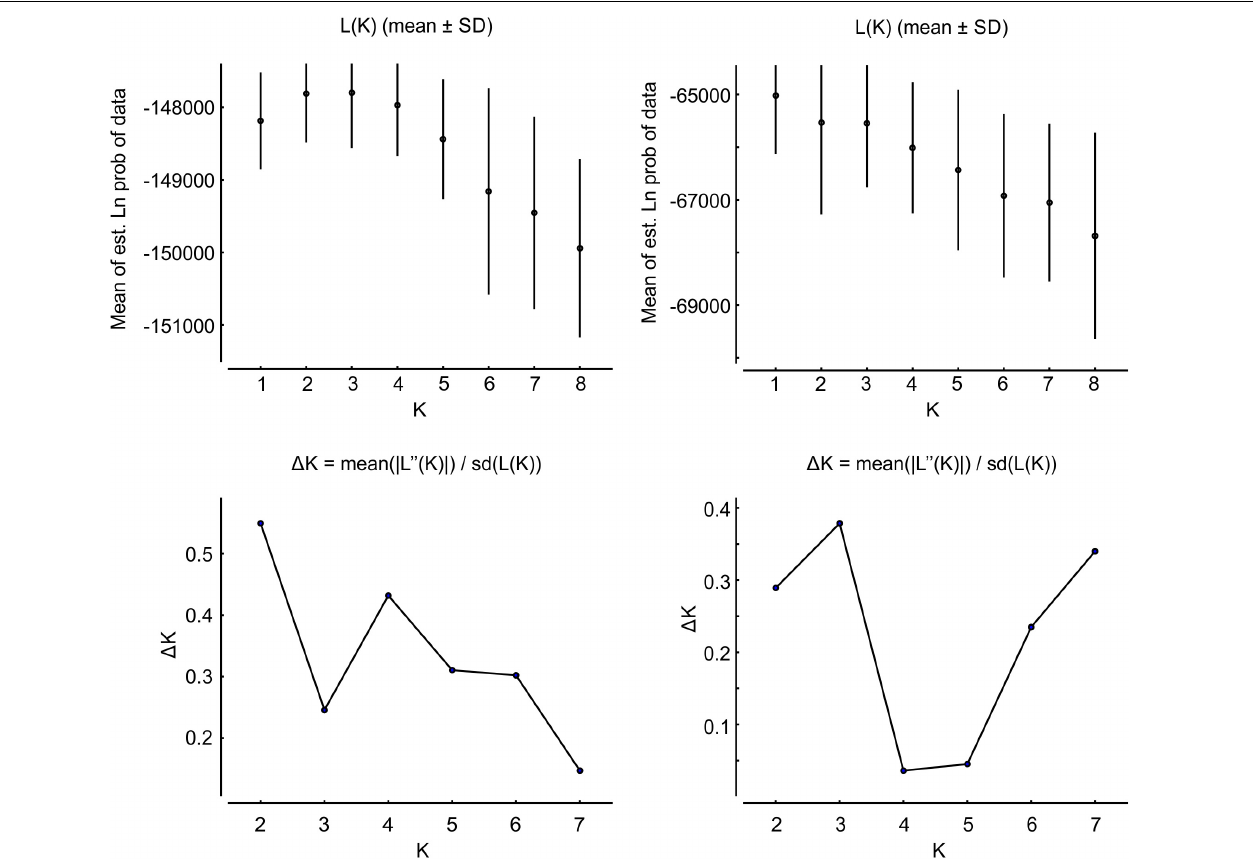
FIGURE 5 | Graphs representing L( K ) and (cid:49) K following Evanno et al. (2005) using combinations of one SNP per tag from all SNPs, and after removing candidates for selection. The most likely clustering level is indicated by the modal value of (cid:49) K , in these cases K = 2 for all SNPs, and K = 3 after removal of those candidate for selection as indicated by BAYESCAN. Other indicator, like L( K ), did not fully agreed with the clustering level indicated. Note that x -axis scales differ between graphs [1–8 for L( K ); 2–8 for (cid:49) K ].